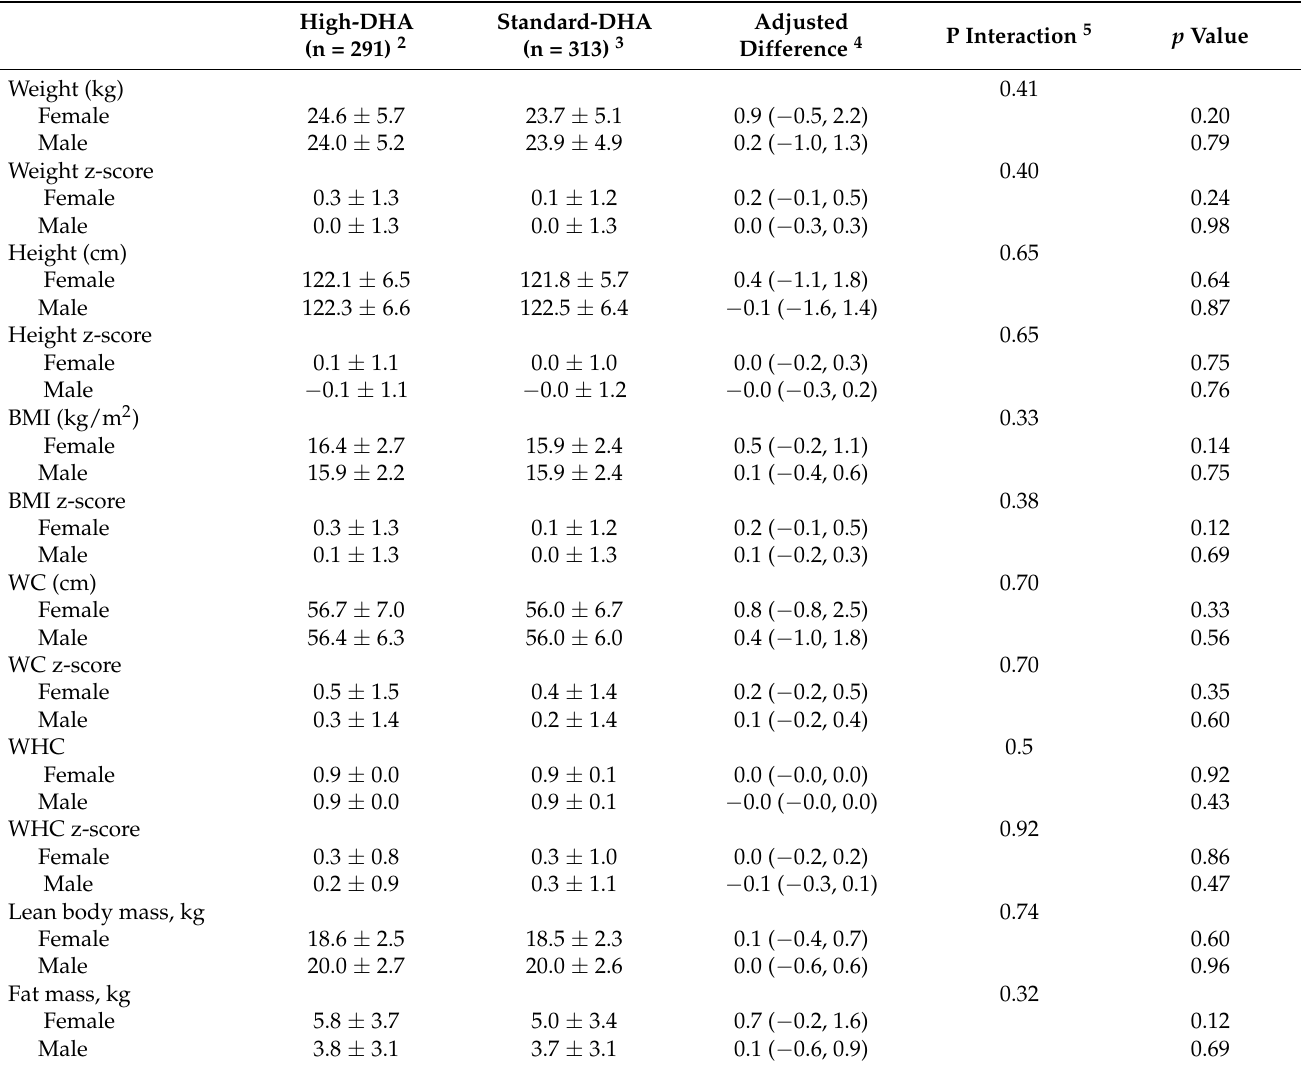
Table 3. Comparison of growth and body composition indicators at 7-year corrected age, stratified by child sex and treatment group 1